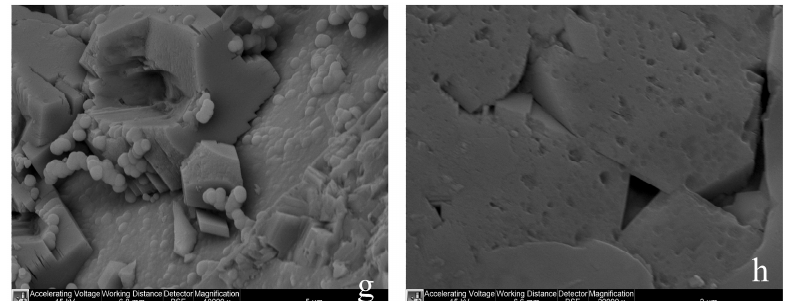
Figure 9. ( a – d ) SEM micrographs of a polished thin section of reacted powder sample R0803,